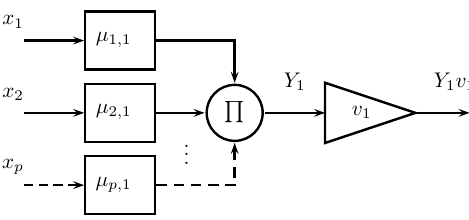
Figure 7. Partial virtual output of the inference